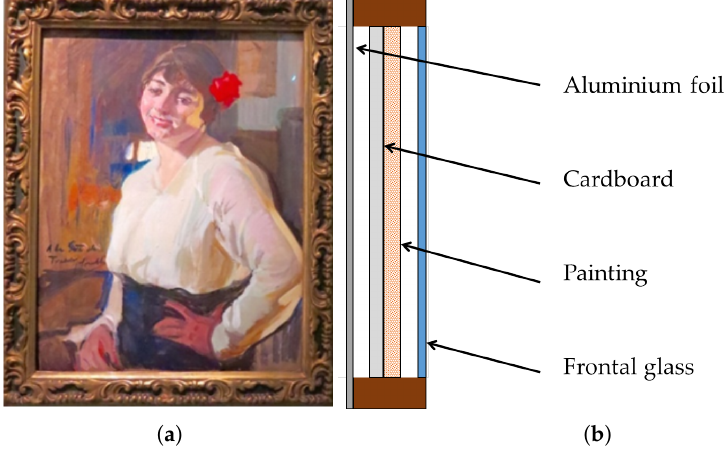
Figure 1. Portrait on cardboard titled “Portrait of a lady with a red flower in her hair” by J. Sorolla ( a ); and schematic cross section of the microclimate frame used and layout of its components ( b